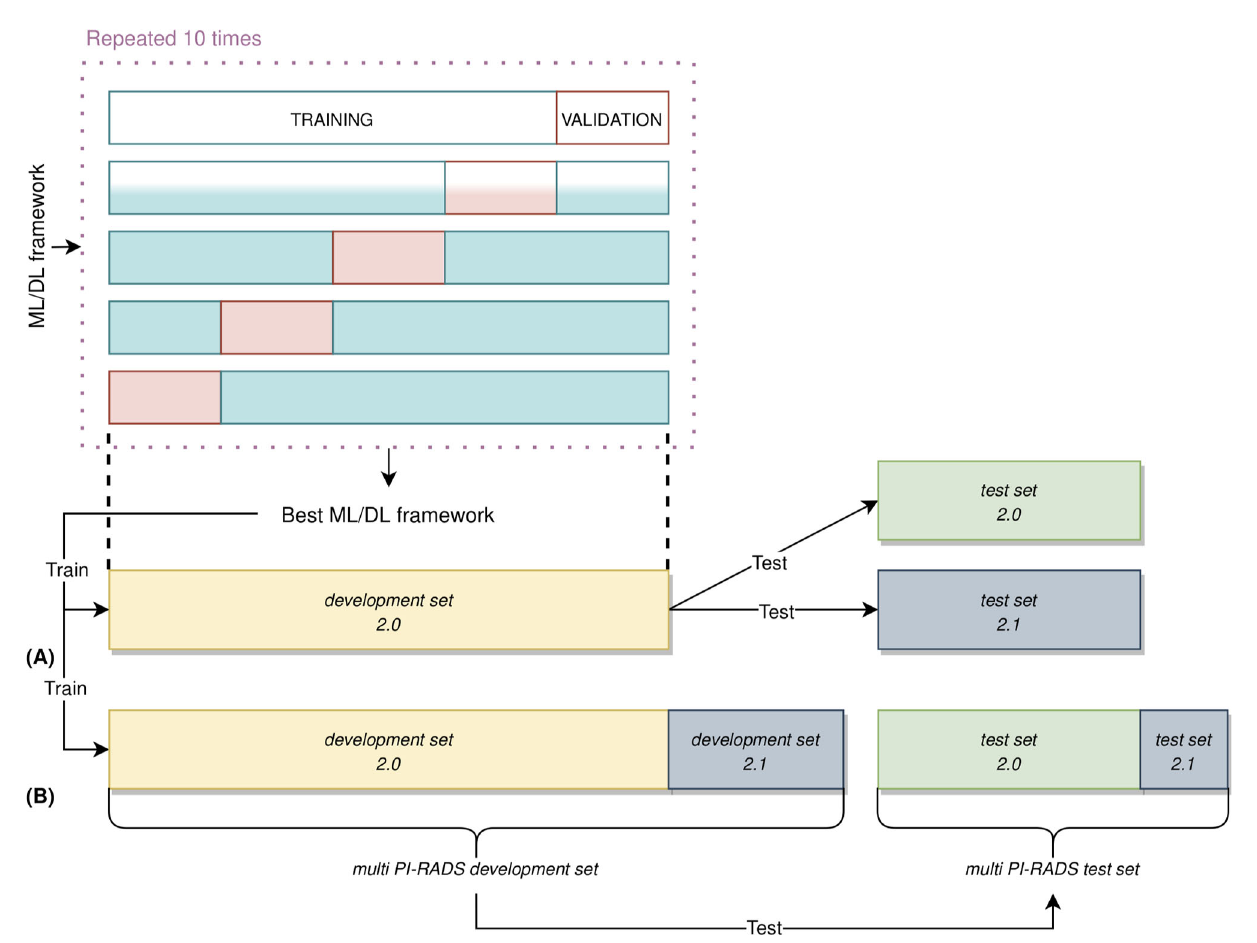
FIGURE 4 | Nested validation scheme in our ML/DL analysis. (A) On development set 2.0 only, 5-fold CV was used to identify the best performing framework, along with performing hyperparameters optimization. The best performing ML/DL framework was then used to train the fi nal framework on the entire development set 2.0. This framework was then evaluated on an unseen test set 2.0 and test set 2.1, independently. (B) The best performing framework was still trained on multi PI-RADS development set (i.e., the union of development set 2.0 and development set 2.1 and evaluated on unseen multi PI-RADS test set (i.e., the union of test set 2.0 and test set